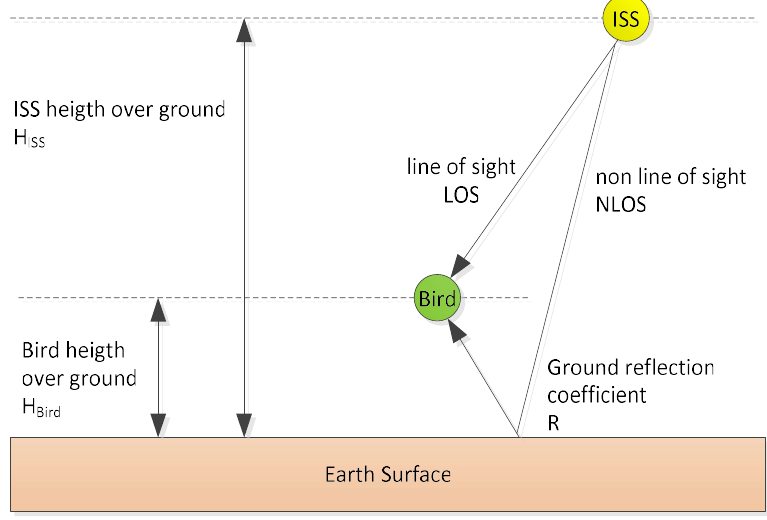
Figure 13. ICARUS Multipath Propagation Scenario.